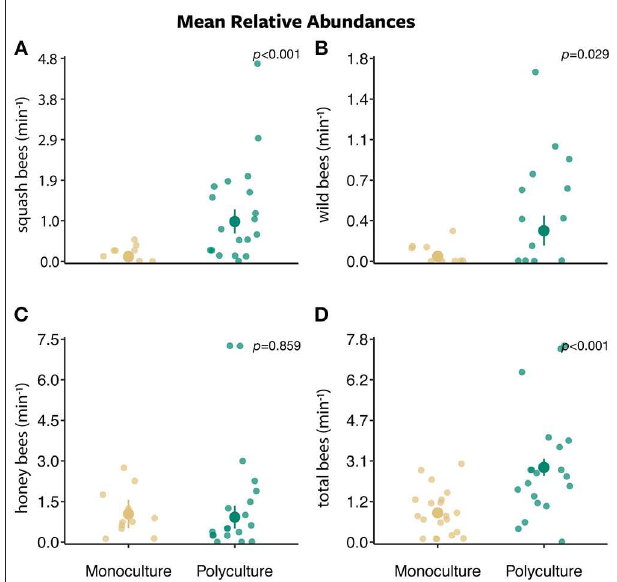
FIGURE 2 | The mean relative abundances ± standard error of (A) squash bees, (B) wild bees, (C) honey bees, and (D) total bees per minute along a 30m transect between two farm types (polyculture and